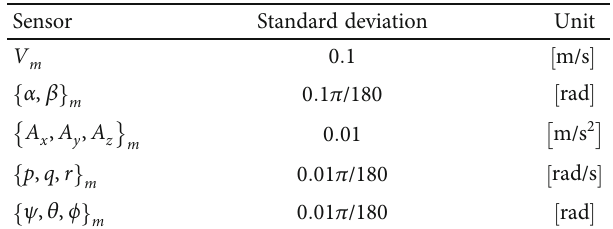
Figure 2: Plots of a sampled fl ight record allocated in our Table 2: Measurement noise standard deviations in the simulation for aircraft D .